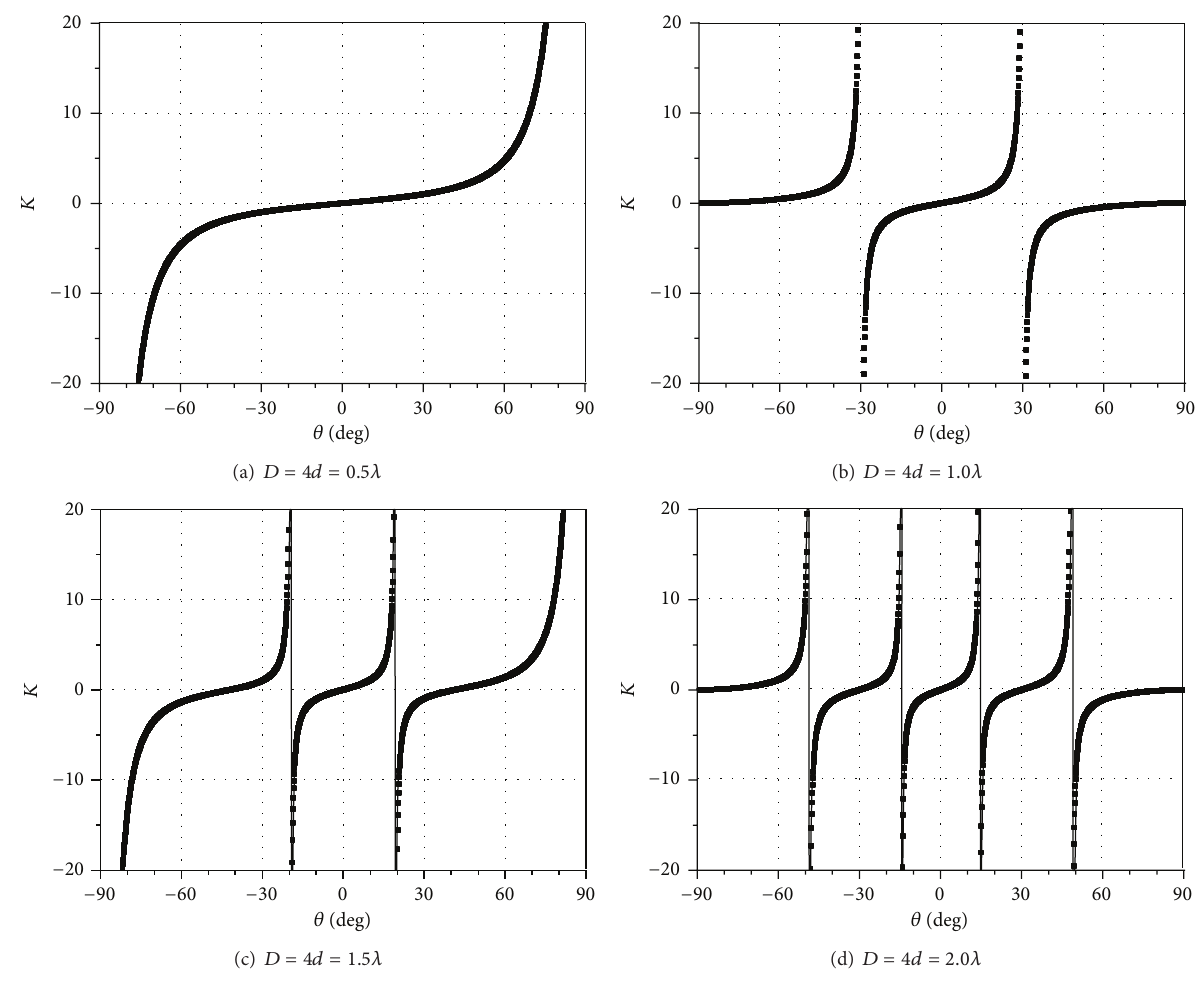
Figure 2: Difference-sum ratio 𝐾 for different subarray distance.